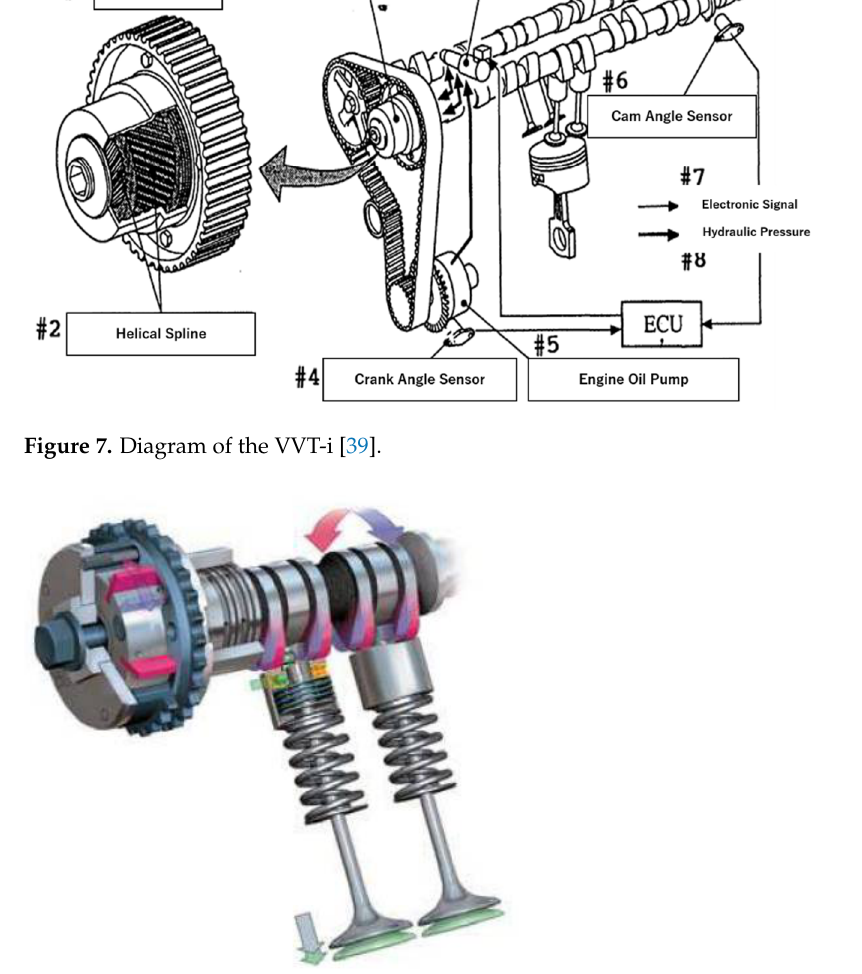
Figure 8. Diagram of the VarioCam (Note: To improve the fuel efficiency and to reduce the amount of emission, the pin unlocks the two lifters) [40].